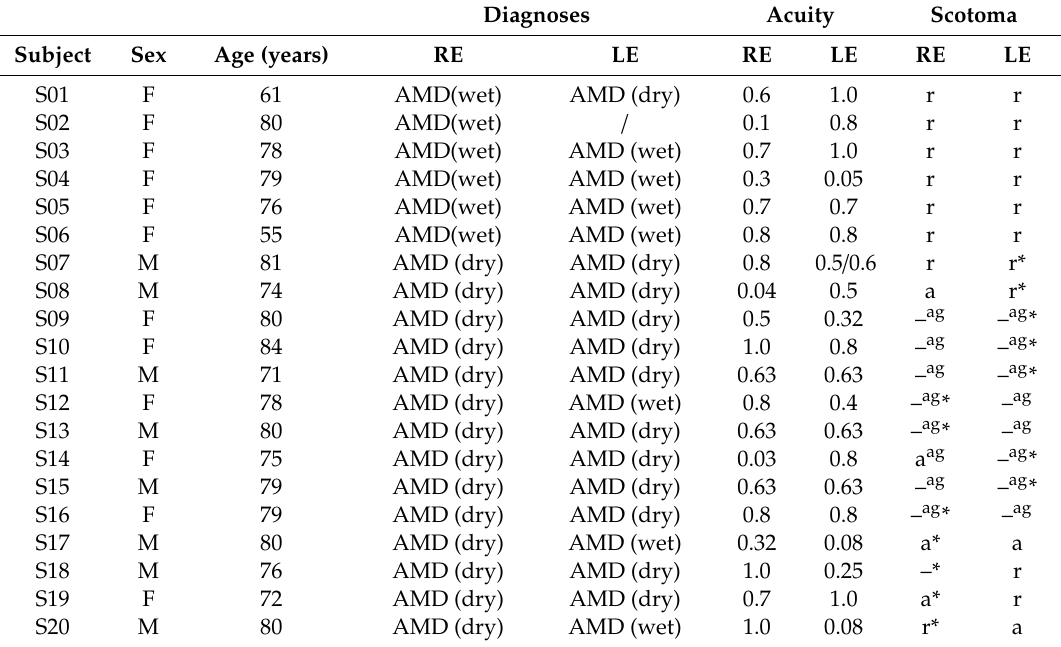
Table 1. Patient characteristics. Notes: RE, right eye; LE, left eye; AMD, age-related macular degeneration; –, no scotoma; r, relative scotoma; a, absolute scotoma; ag , tested with Amsler grid; * tested eye. Patients S1–S6 were tested